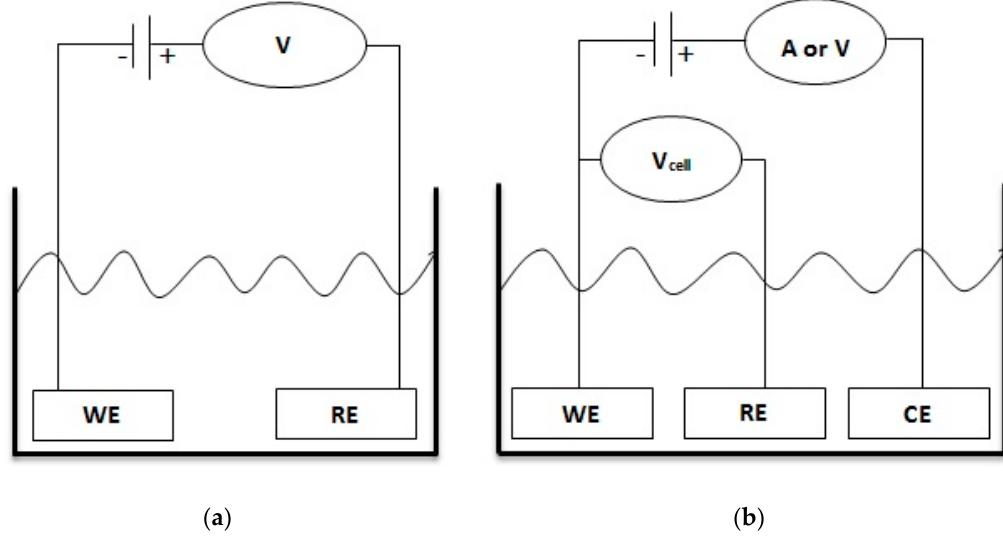
Figure 1. Schematic images of ( a ) a two electrode setup for potentiometric measurements showing its self-powered sensing ability without any external battery/power source, ( b ) a three electrode setup for amperometric/voltammetric measurements with an external power source.